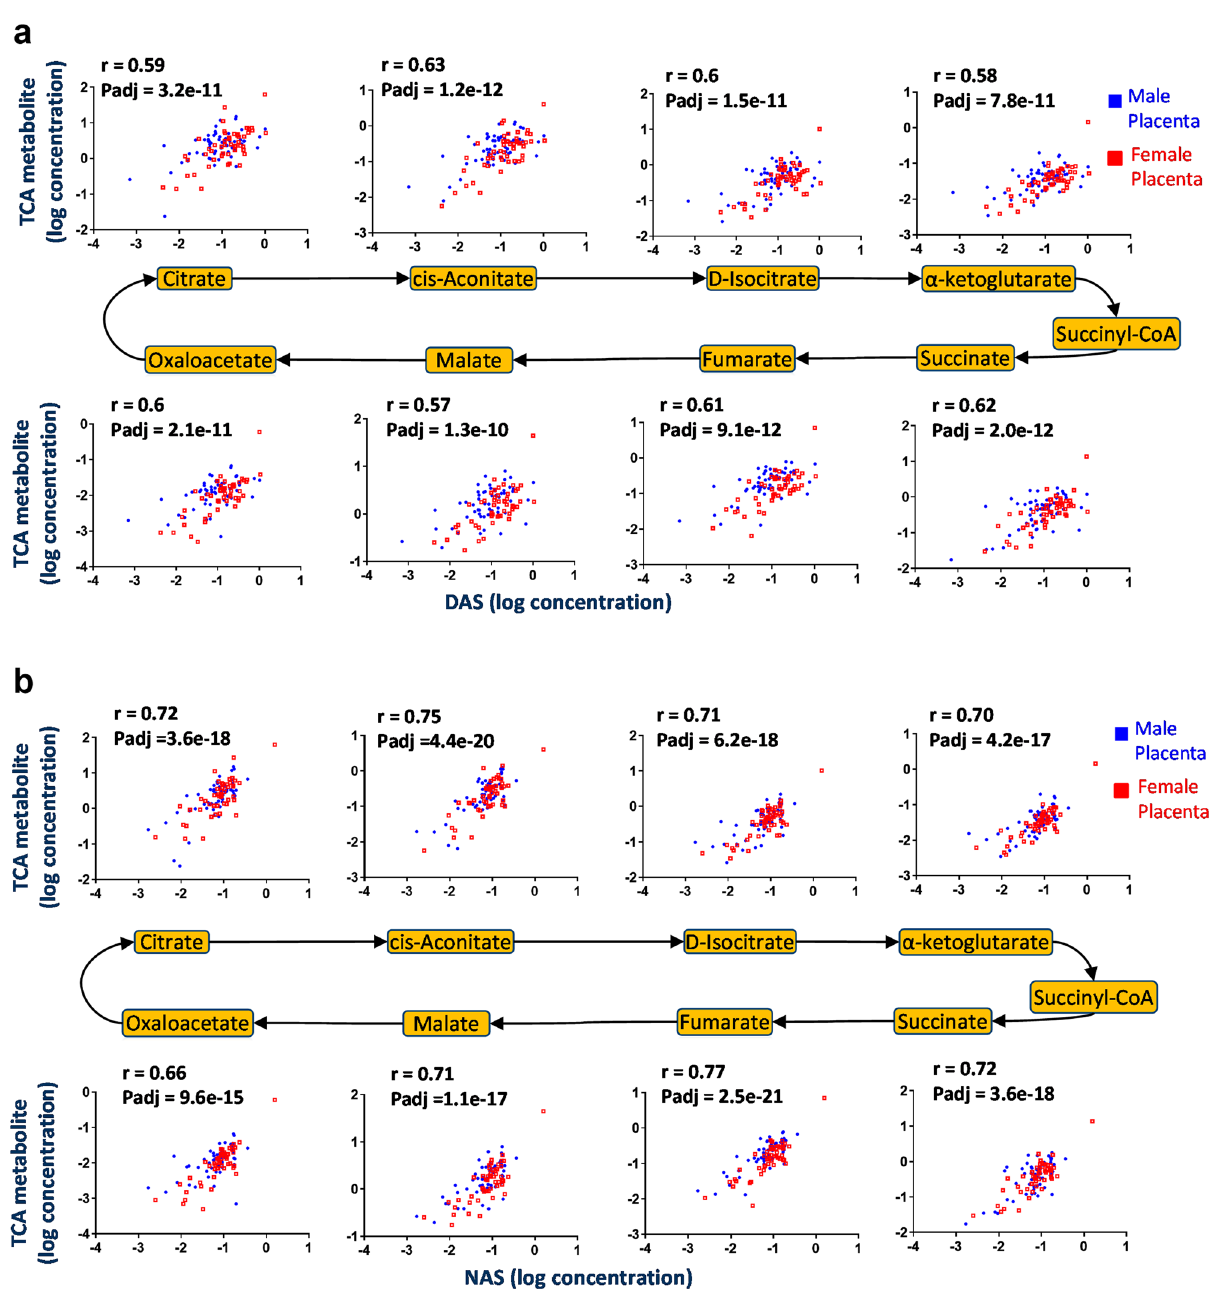
Fig. 2 Correlations between TCA cycle intermediates and polyamine end metabolites. Scatter plots of TCA cycle intermediates versus ( a ) DAS or ( b ) NAS in human placental tissues. Metabolite concentrations measured by LC-MS were log transformed and Pearson ’ s correlation analyses performed. r = Pearson ’ s correlation coef fi cient. P -adj = P -values corrected for FDR by Benjamini – Hochberg method. DAS: N1,N12-diacetylspermine; NAS: N1- acetylspermidine. N = 59 male placentas and N = 51 female